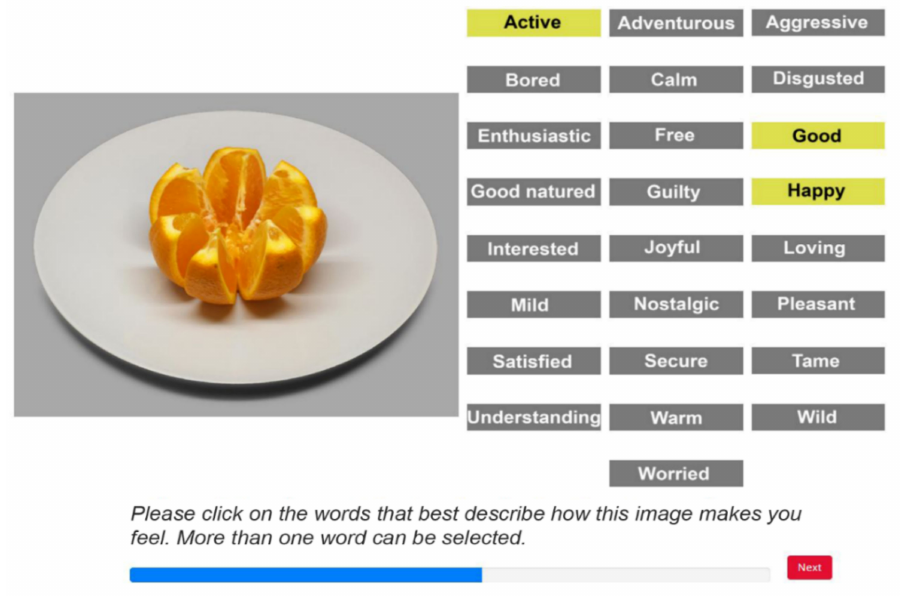
Figure 7. Screen layout of the Image2Label task: mapping food images to EsSense25 terms. Selected terms became highlighted in yellow. In this example the participant responded “active”, “good” and “happy”. A blue progress bar indicated the progression of the